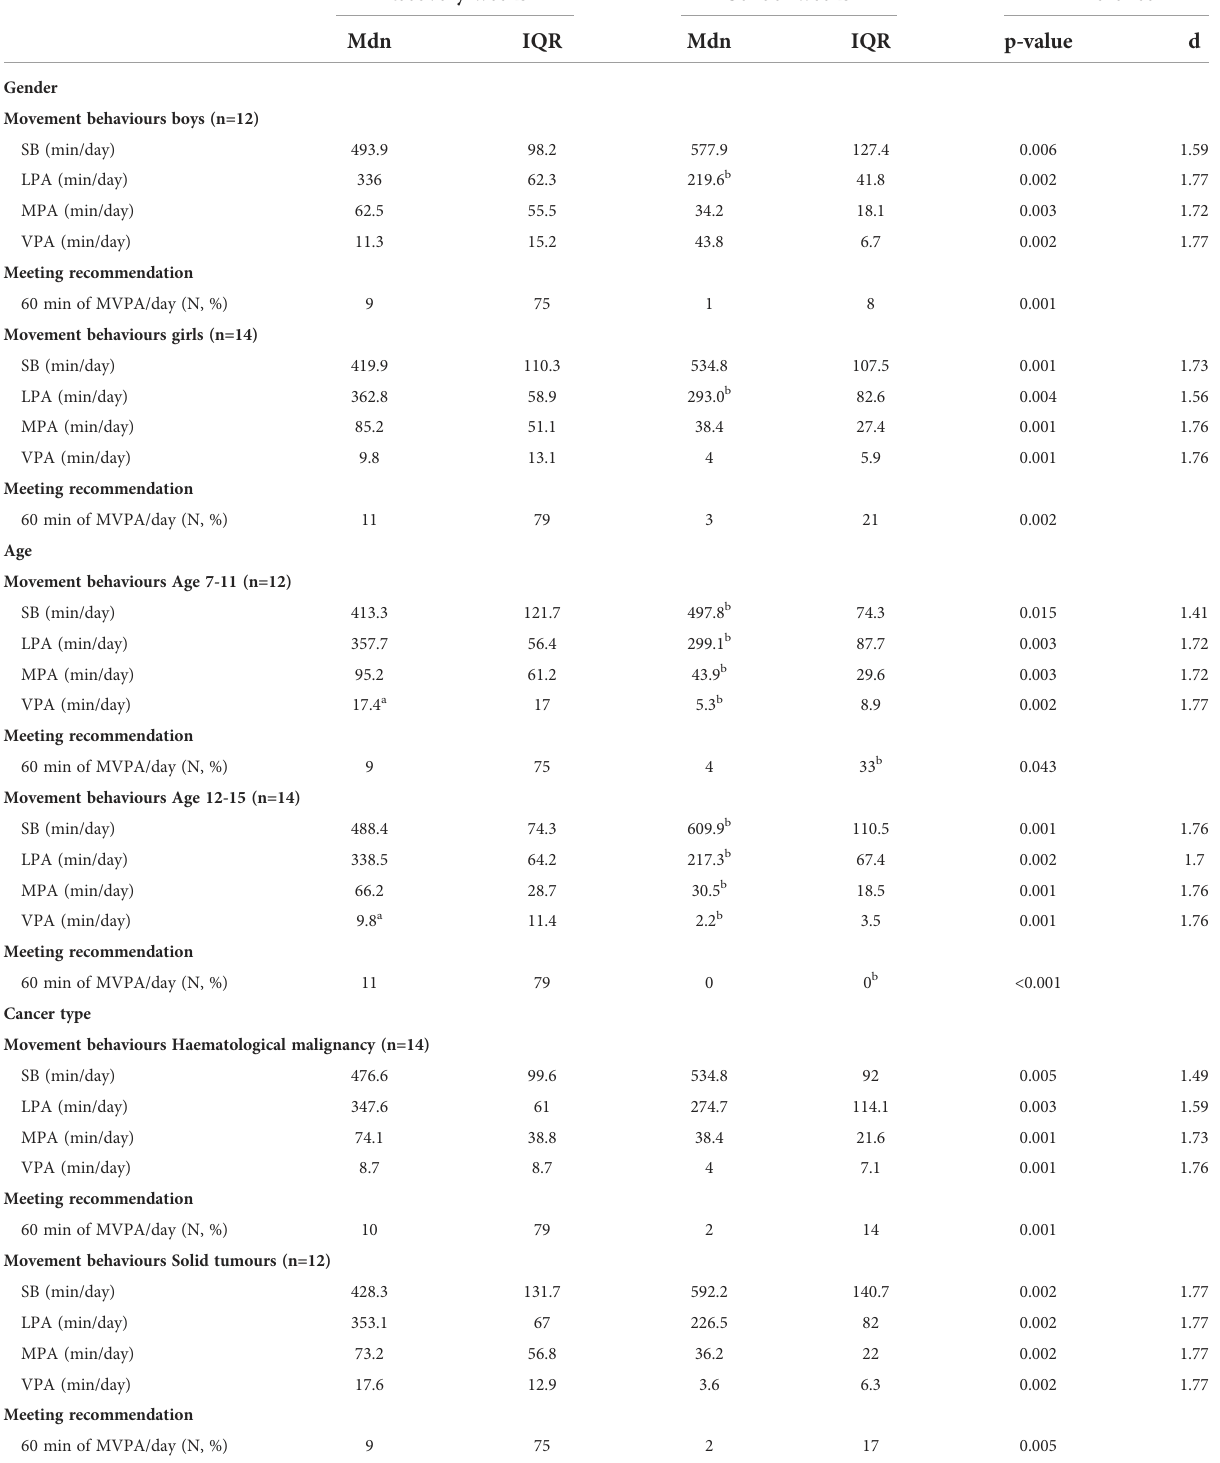
TABLE 3 Movement behaviours and meeting recommended PA level in paediatric cancer survivors during recovery and school weeks in different gender, age, and cancer type groups. Recovery weeks School weeks Difference Mdn IQR Mdn IQR p-value